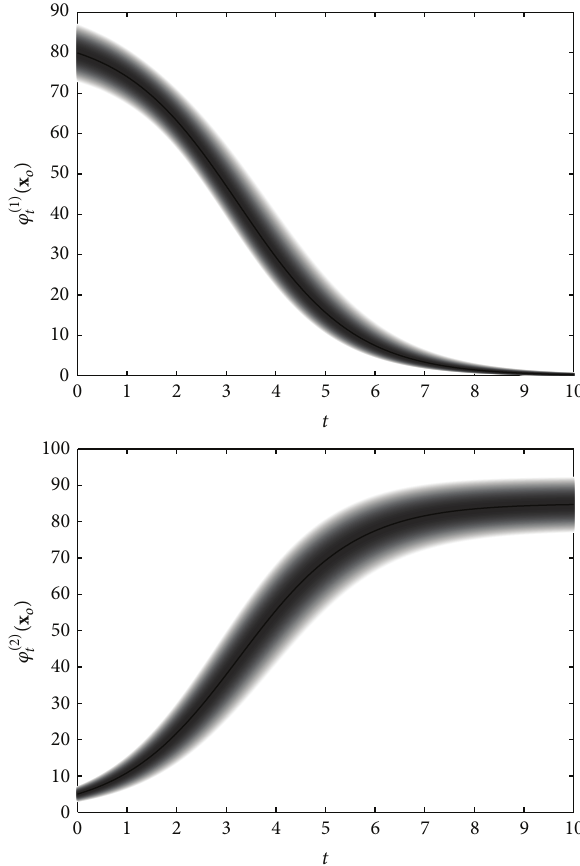
According to what is discussed in [3], for all x 𝑜 ∈ F ( R 2 + ) , the fuzzy solution ̂𝜑 converges to the equilibrium point fuzzy = ̂𝑥 ( x ) . x 𝑒 𝑒 𝑜